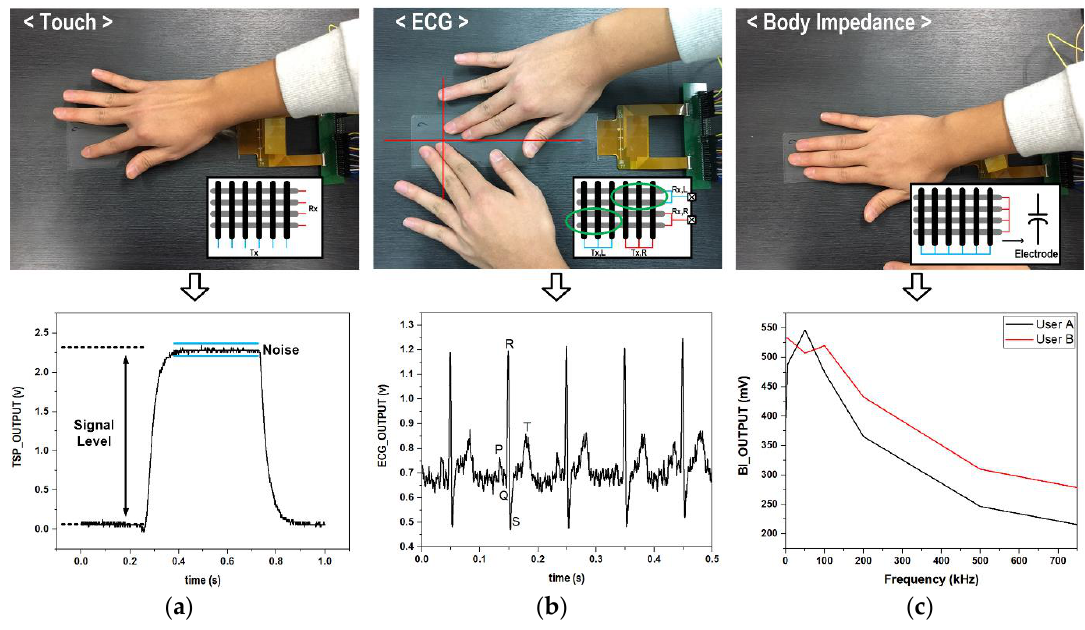
Figure 8. Measurement results of touch screen panel (TSP)-based sensing functions: ( a ) touch, ( b ) electrocardiogram (ECG), and ( c ) body impedance.